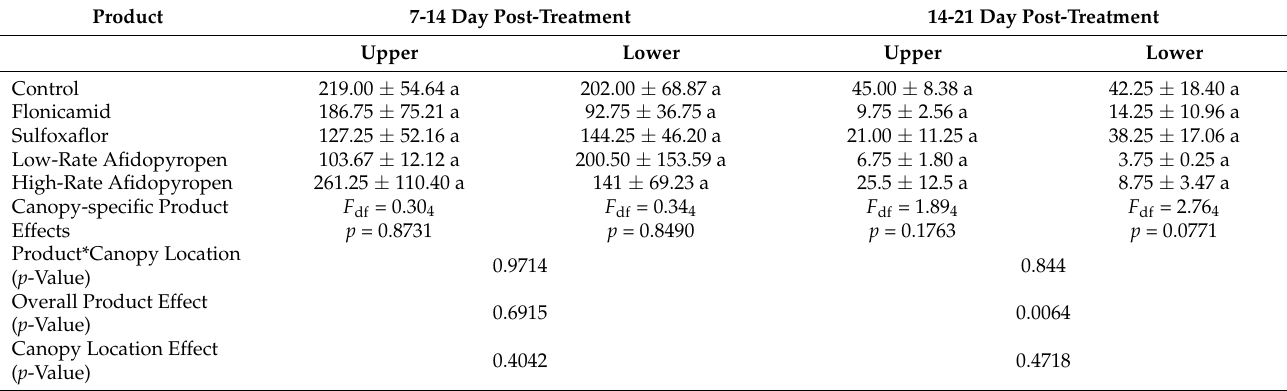
Table 6. Mean + SEM of adult parasitoids per card across treatments and sample days in 2020. Differing letters in columns indicate a significant difference between treatments ( p < 0.05 Tukey’s HSD). Canopy-specific product effects and p -values for product*canopy interaction, overall product effect, and canopy location across sampling days are also shown. Application rates for each aphicide are based on the standard label